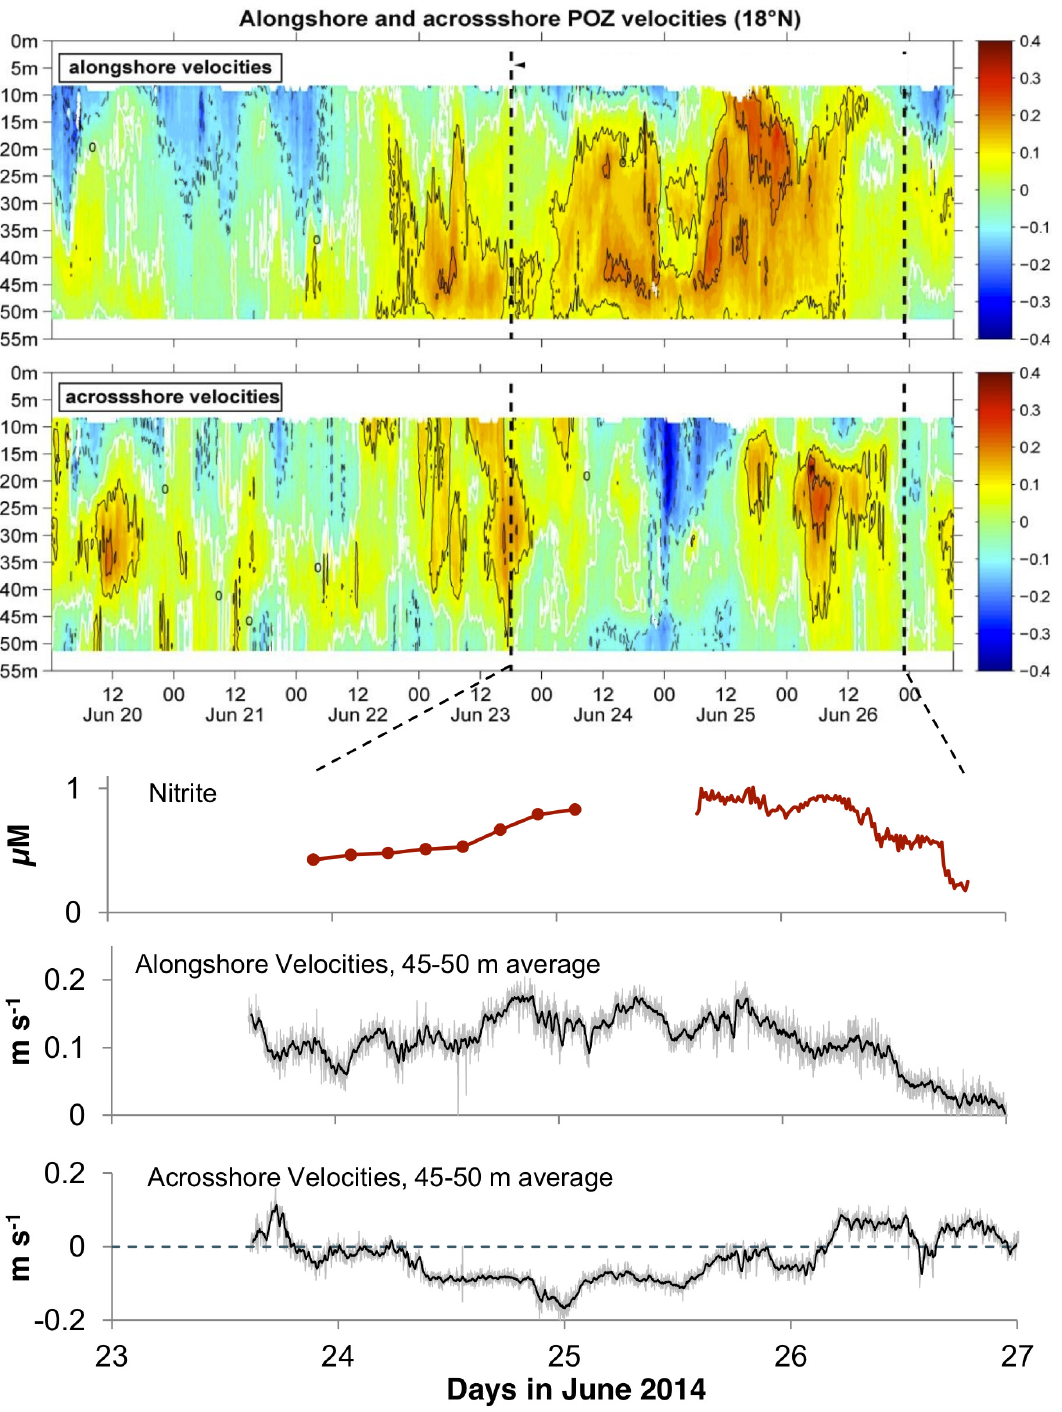
Fig 7. Alongshore and across shore velocities (m s -1 ) at the 50 m site. The velocities were measured with an upward-looking ADCP on a lander at 50m on the 18° N transect. Positive alongshore velocities values stand for northward flow while positive across shore velocities represent flow towards the shore. The NO 2- ( μ M) series shown in Fig 4 are also added to indicate that the high- NO 2- periods were associated with strong positive alongshore velocities and negative across shore velocities.